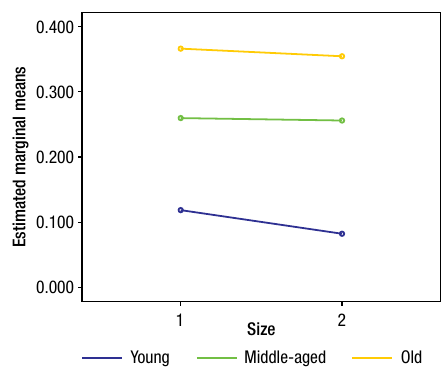
Fig. 2. EXTERNAL EQUITY Variable